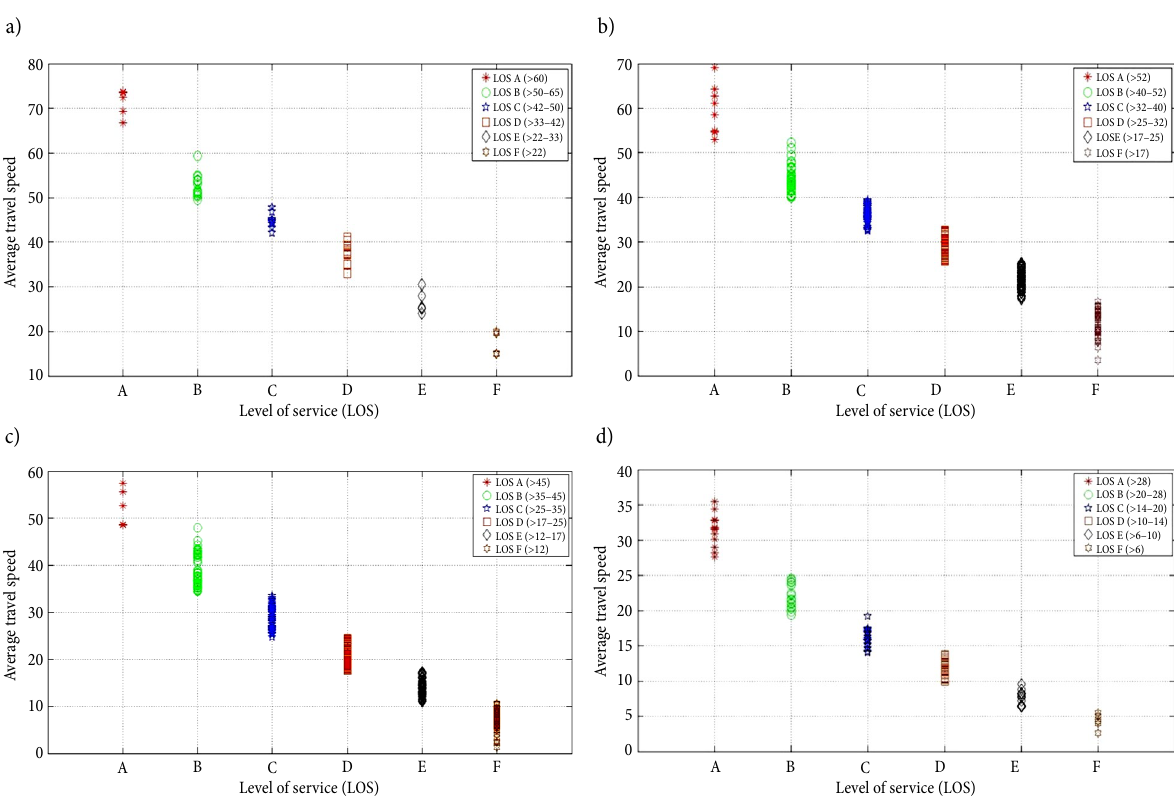
Fig. 5. LOS of urban street classes (I–IV) using AP clustering on average travel speed: a – LOS of urban street class-I; b – LOS of urban street class-II; c – LOS of urban street class-III; d – LOS of urban street class-IV